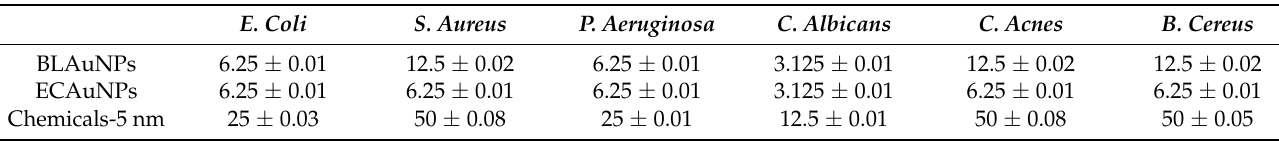
Table 1. Minimum inhibitory concentrations (mg/L) of BLAuNPs, ECAuNPs, and chemically synthesized AuNPs (5 nm) against tested strains.